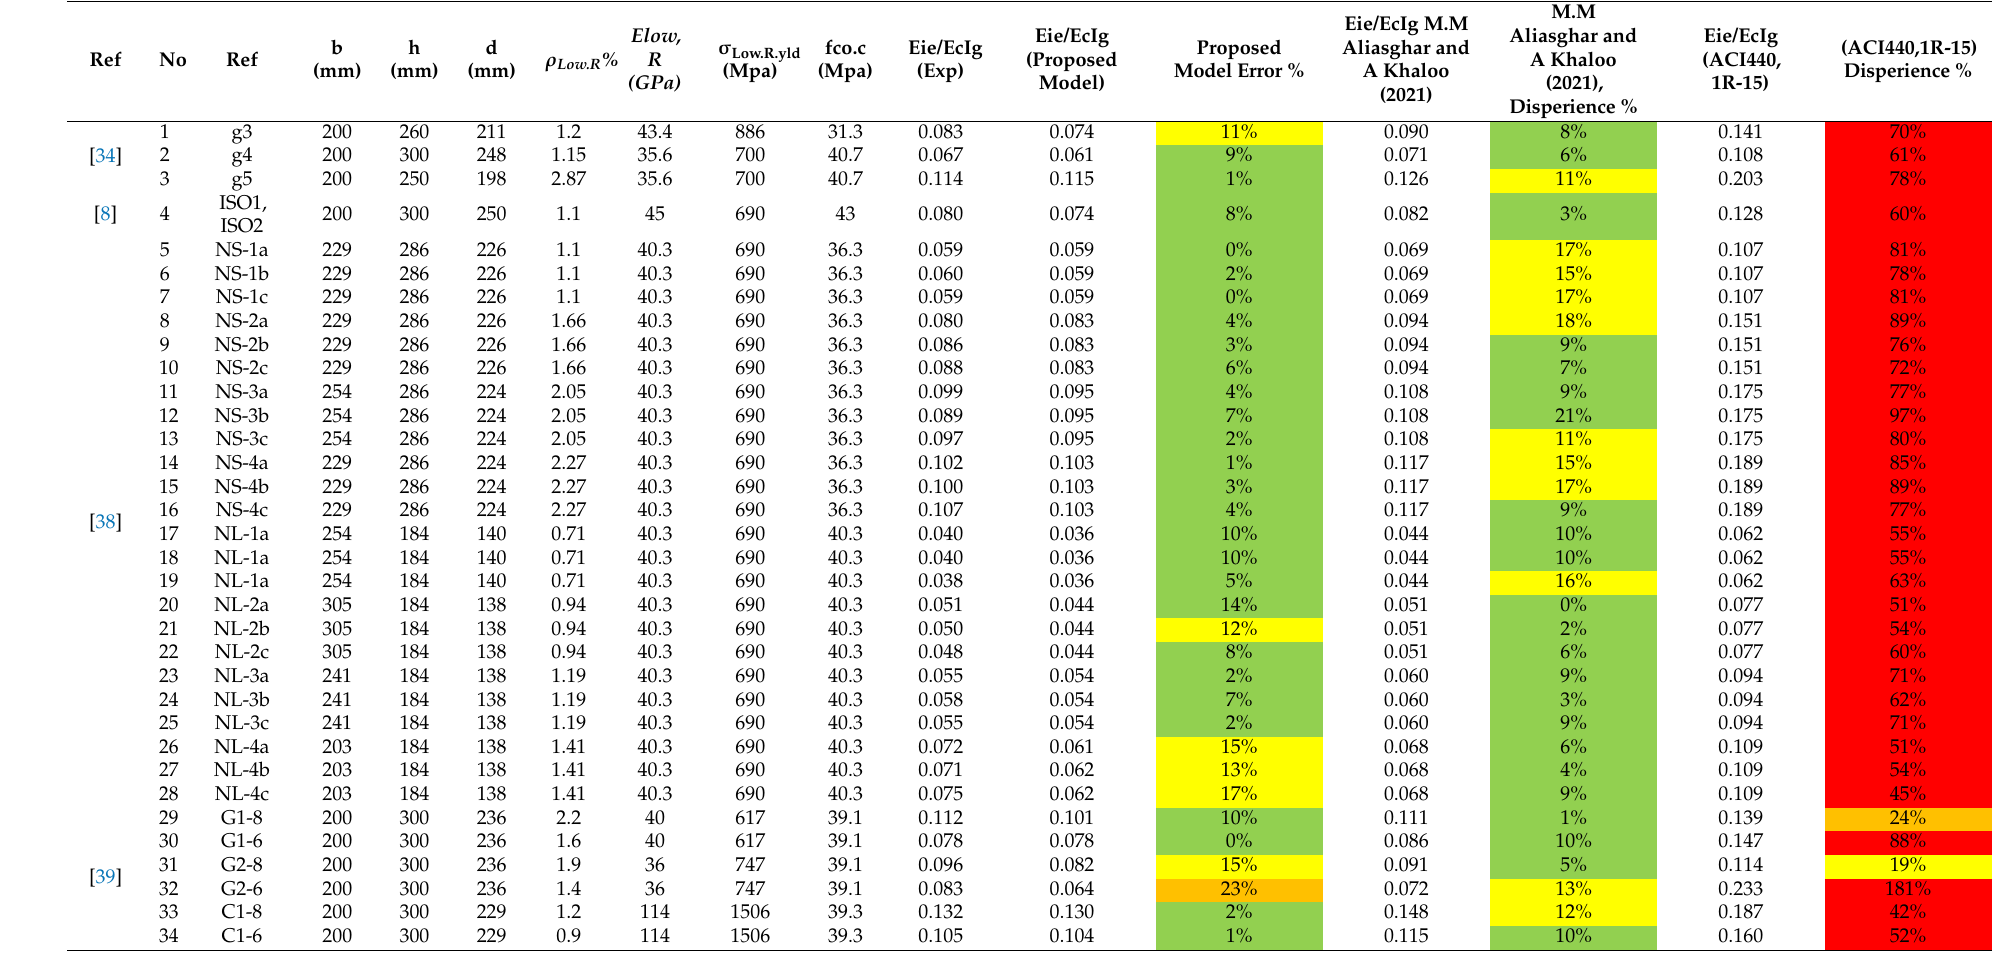
Table 6. (EFS) Accuracy comparison of present model with experimental data, M.M Aliasghar and A Khaloo (2021) and (ACI 440.1R-15) formulations for FRP RC beams (the background colour shows the level of